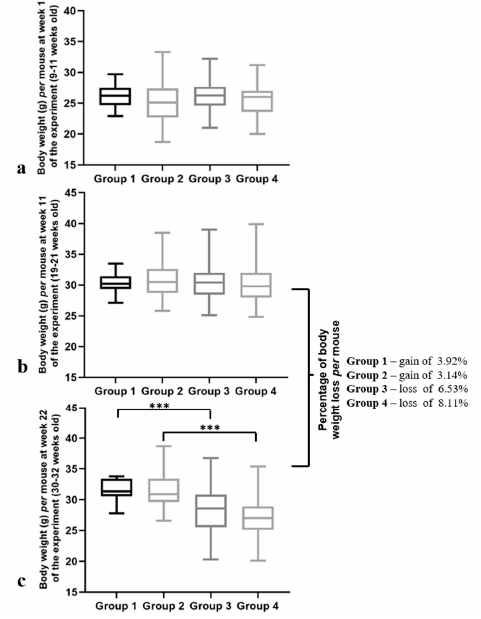
Figure 4. Body weights per mouse at different time points of the experiment. ( a ) Body weight per mouse at Week 1 (9–11 weeks old). Mice of all the groups presented similar body weights at this time point ( p = 0.100). ( b ) Body weight per mouse at Week 11 (19–21 weeks old). The body weights of all the groups remained similar ( p = 0.784). ( c ) Body weight per mouse at Week 22 of the experiment (30–32 weeks old). A significant decrease in the body weights of the transgenic mice was observed (*** p < 0.001). Comparing the body weights at Weeks 11 and 22, there was a weight gain in the HPV − mice and a weight loss in the HPV + mice (6.5% in Group 3 and 8.1% in Group 4). Group 1: HPV − without DMBA application ( n = 10); Group 2: HPV − with DMBA application ( n = 10); Group 3: HPV + without DMBA application ( n = 10); Group 4: HPV + with DMBA application.